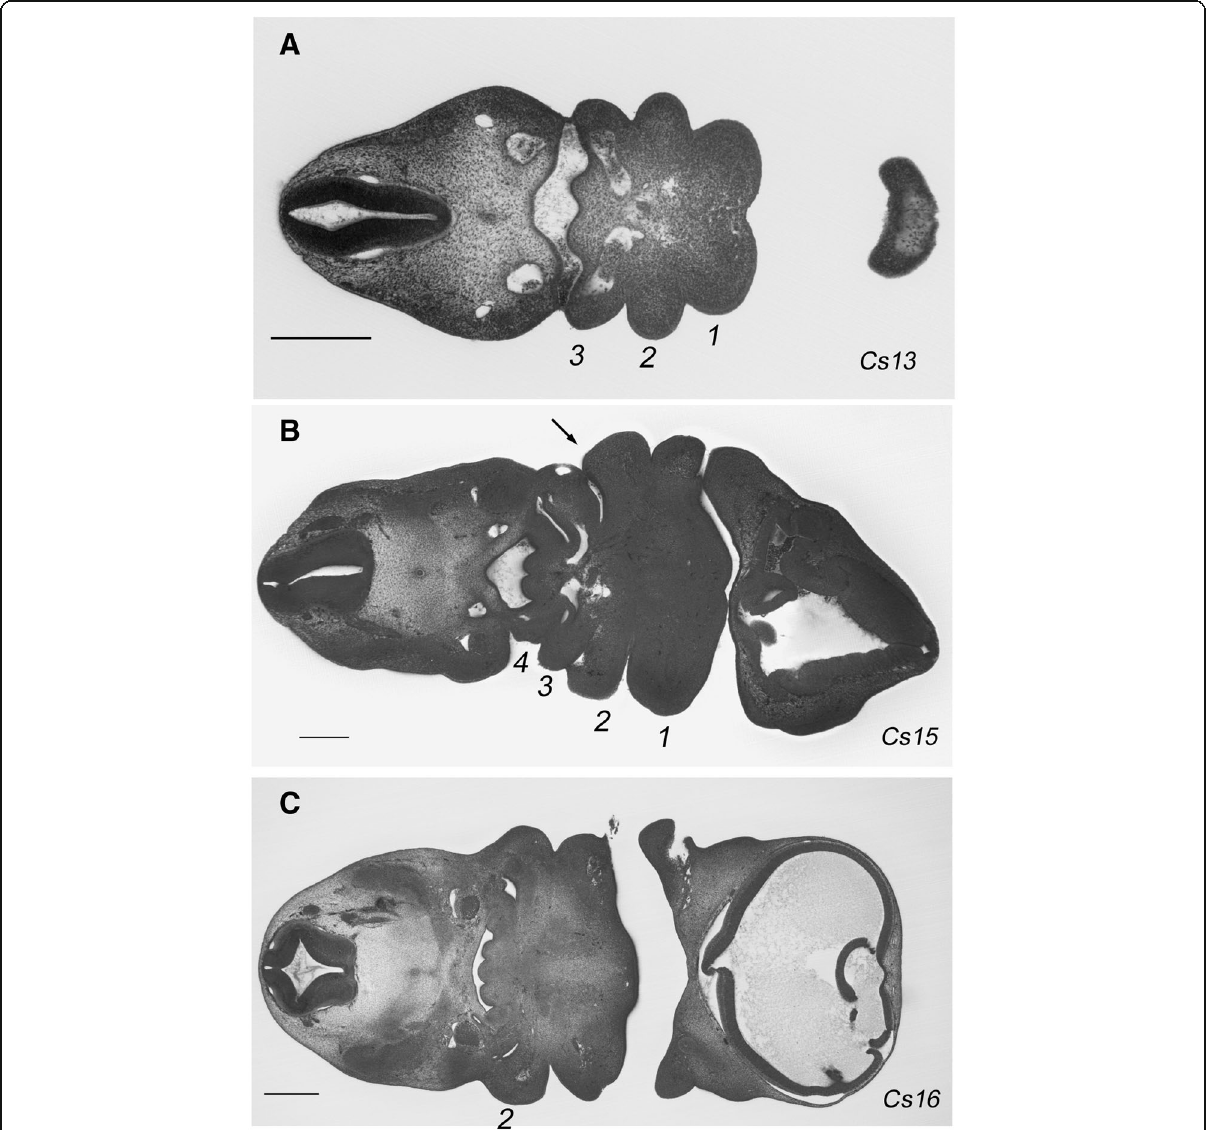
Fig. 1 Segmental and post-segmental stages of pharyngeal development in human embryos. In this figure High-Resolution Episcopic Microscopy (HREM) data from the human embryos from the DMDD website (https://dmdd.org.uk/) is shown. a At Carnegie Stage (Cs) 13, the first three most anterior pharyngeal arches have formed and are morphologically evident. b By Cs 15 stage, a further fourth arch has formed. c However, by Cs16 the segmental nature of the pharyngeal region has been lost as the second arch has overgrown the posterior arches, covered and subsumed them. Scale bar = 0.25